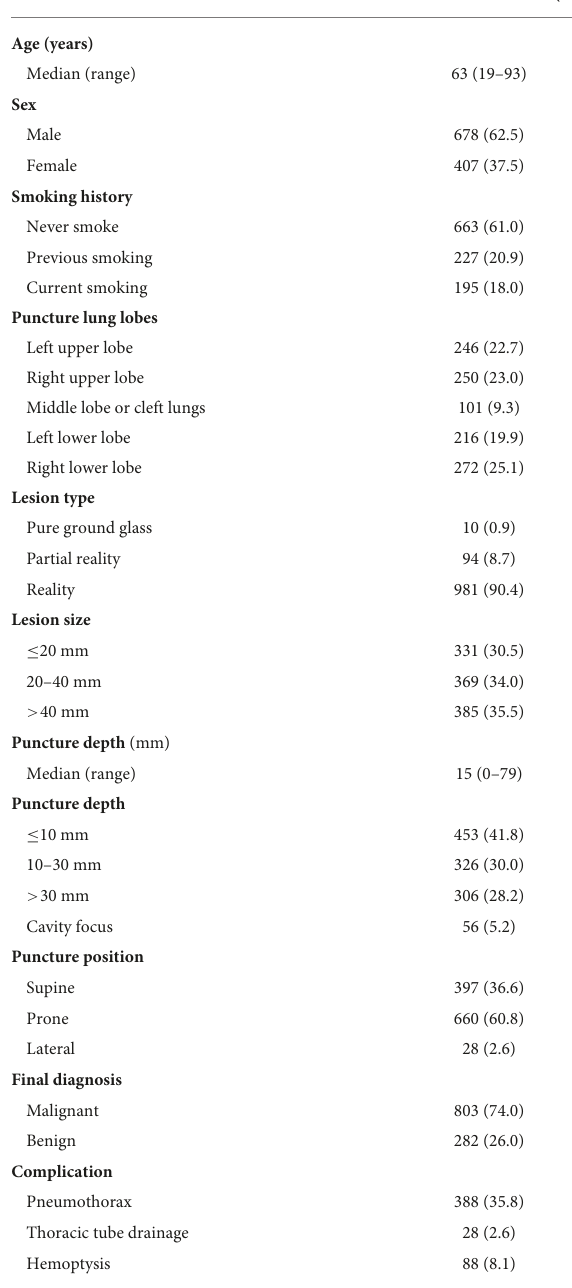
TABLE 1 General patient information related to biopsy ( n =